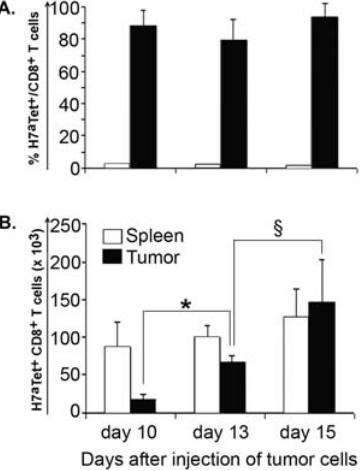
Figure 2. Anti-H7 a T cells accumulate in the tumor. We treated B10 recipient mice as described in Fig. 1. Cell suspensions from their spleen and tumor were obtained on day 10, 13 and 15, and stained with H7 a tetramers and anti-CD8 antibody. A) Proportion and B) absolute numbers of H7 a tetramer-positive CD8 T cells in 3–5 mice studied at each time point. * P , 0.01; 1 P ,